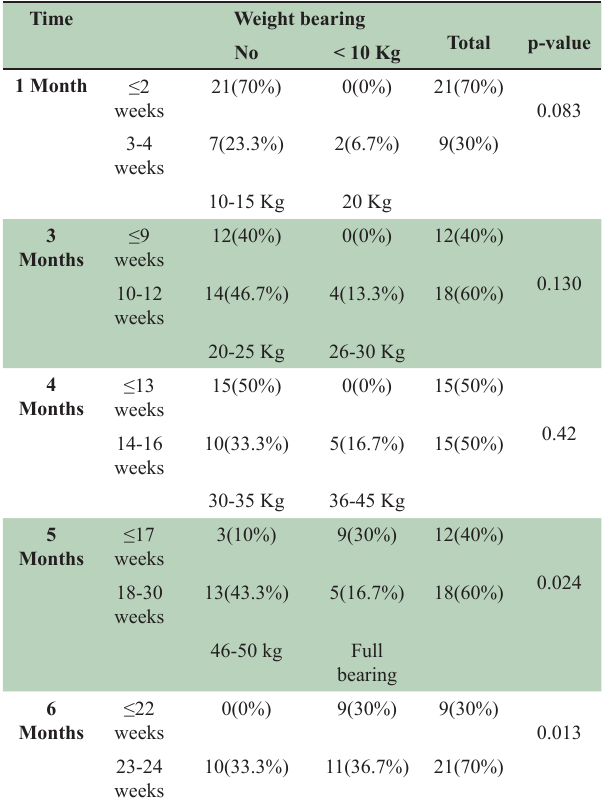
Table-III: Weight-bearing at different follow up time